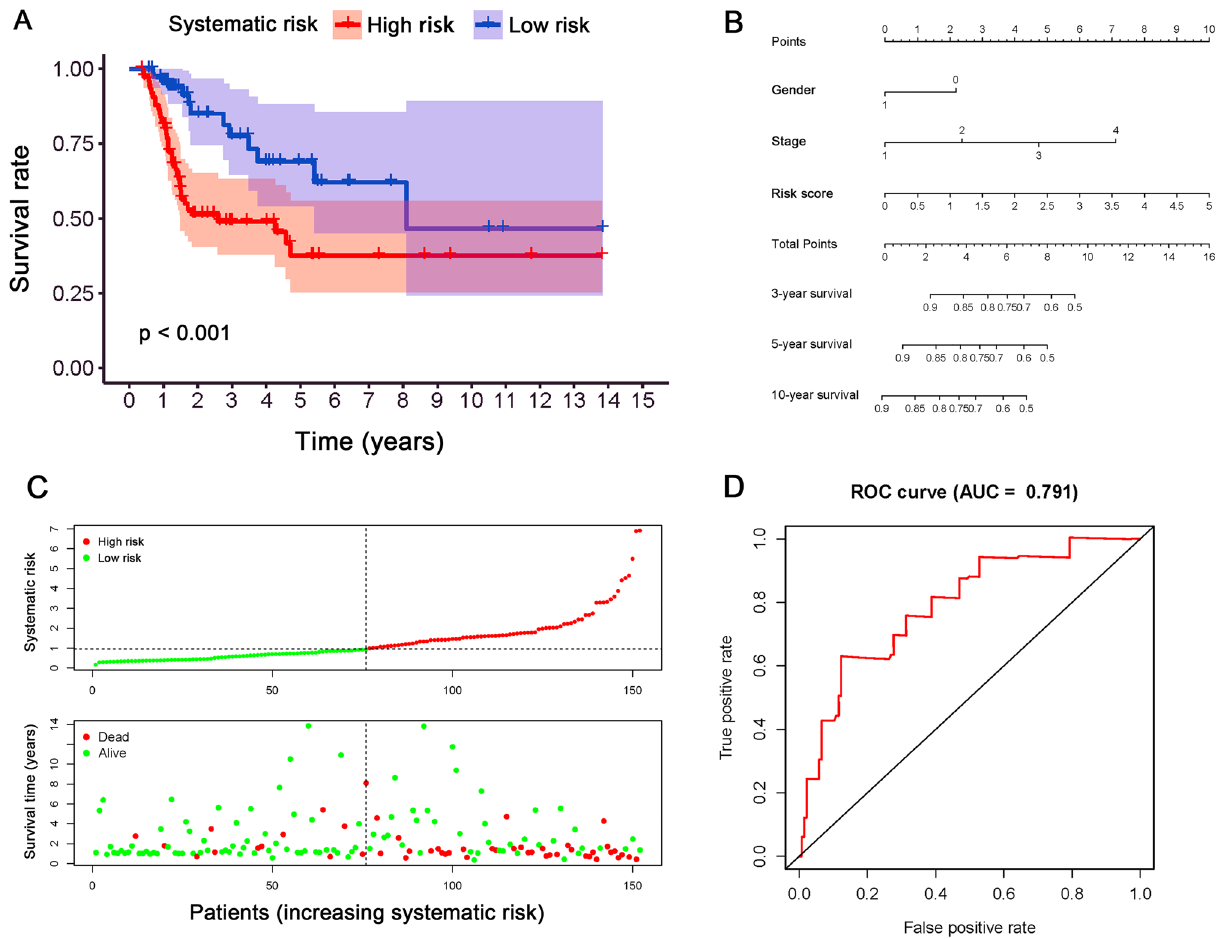
Figure 9. The construction and validation of PDEARGs-based systematic prognostic signature. ( A ) Survival analysis between two groups with different systematic risk. The 95% confidence interval was shown as a light- colored background around the Kaplan–Meier curve. ( B ) Nomogram of the systematic prognostic signature. ( C ) Risk plot encompassing the distribution of systematic risk and survival status of each patient. ( D ) ROC curve analysis of systematic